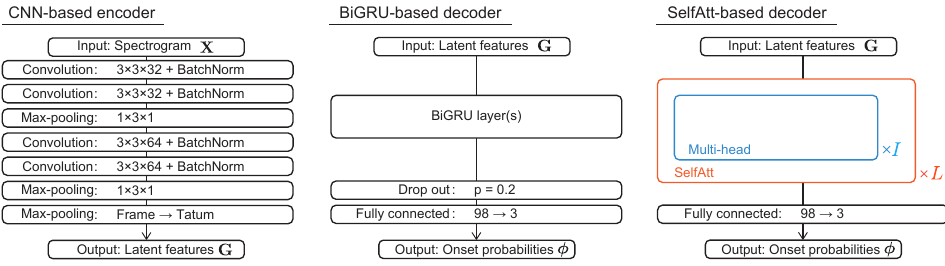
Figure 5. Configurations of the transcription models (CNN-BiGRU and CNN-SelfAtt).